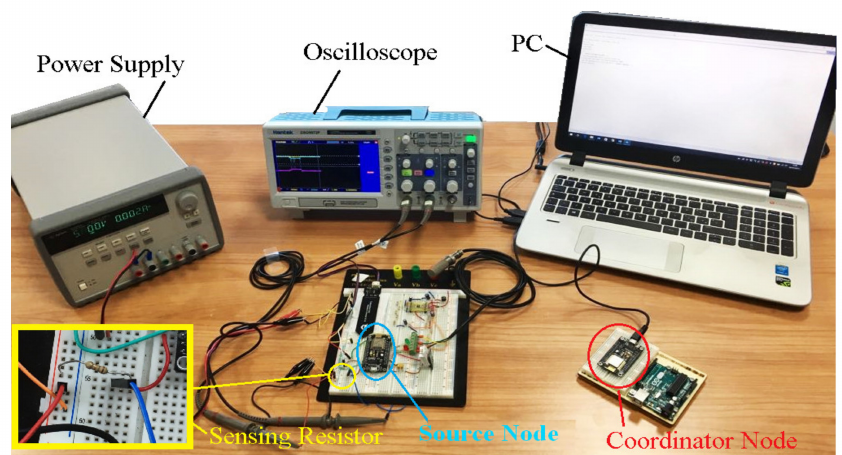
Figure 12. Experimental setup to determine sensor node power consumption in the di ff erent functioning modes, namely coordinator node searching-data acquiring and transmission–deep sleep mode.